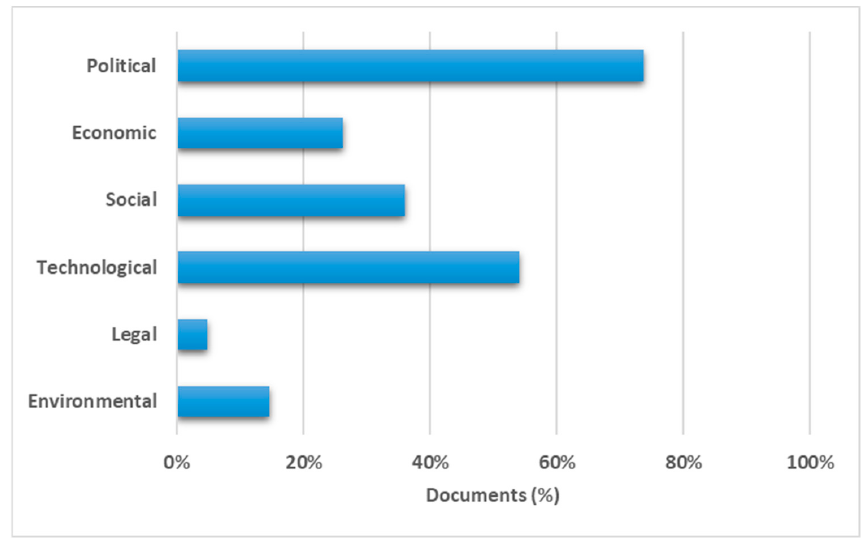
Figure 8. Share of reviewed papers that highlight a determinant of a specific PESTLE category as the determinant of highest importance regarding EV adoption by consumers .